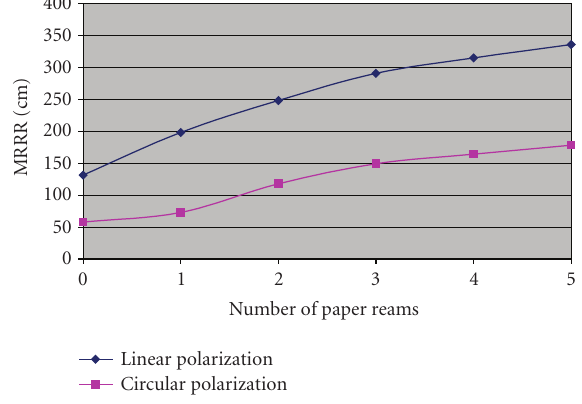
Figure 9: The e ff ect of paper reams on